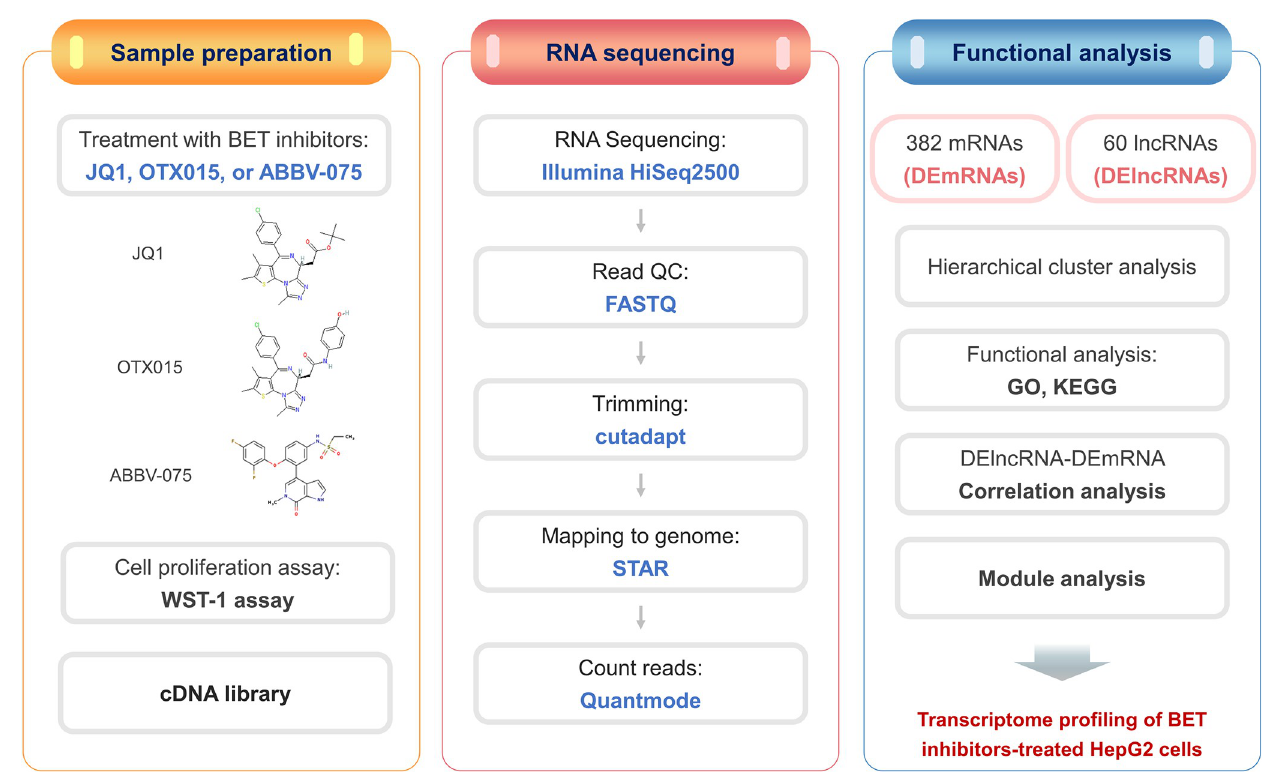
Fig 1. Flow chart of bioinformatics analysis of DEmRNAs and DElncRNAs. DEmRNAs; differentially expressed mRNAs, DElncRNAs; differentially expressed lncRNAs, GO; gene ontology, KEGG; kyoto encyclopedia of genes and genomes.